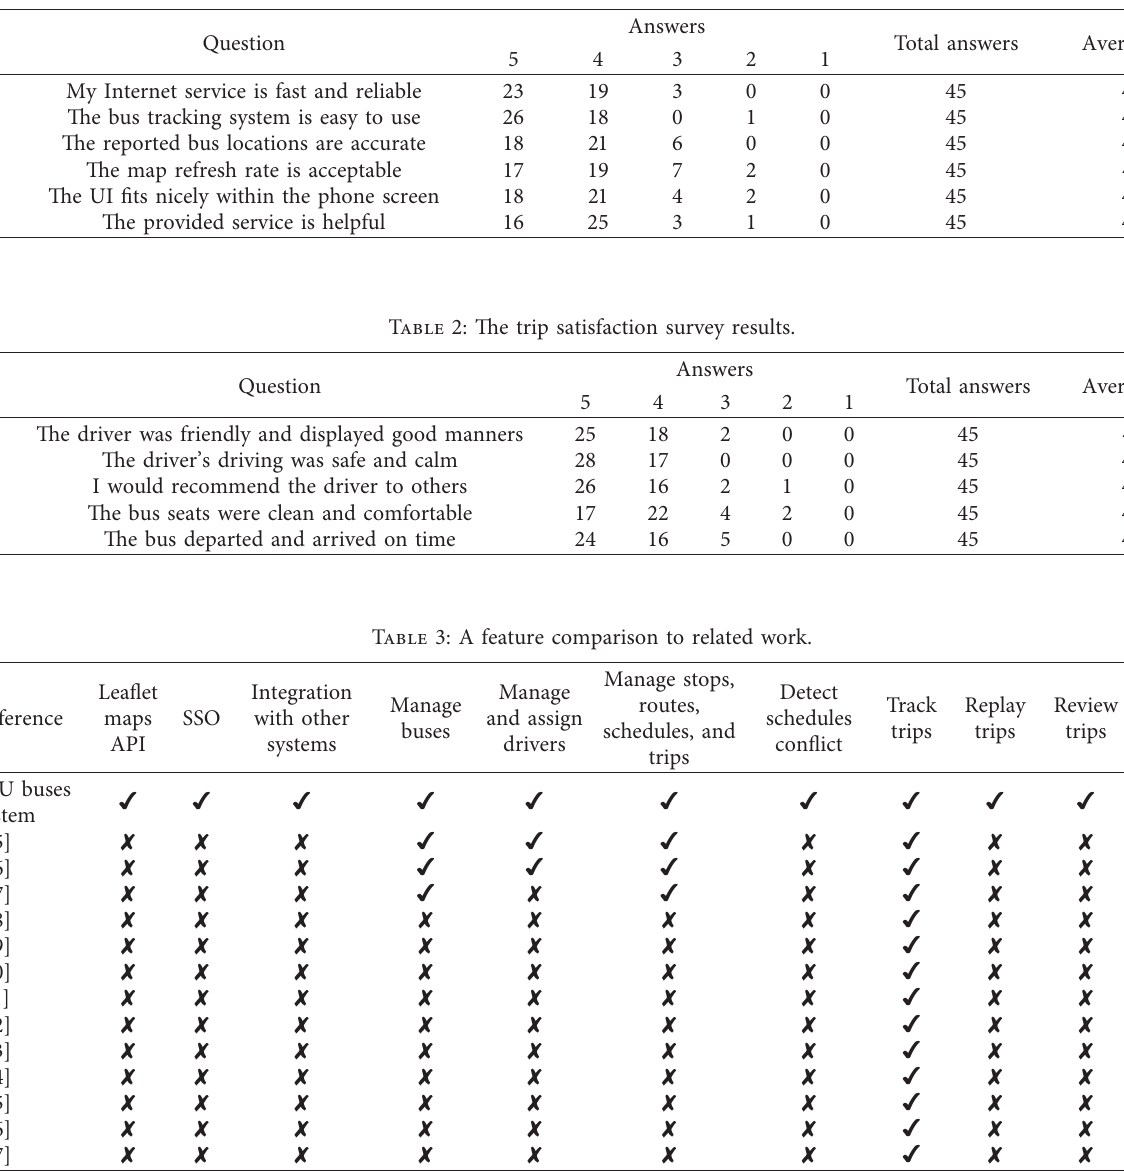
Table 1: The system assessment survey results.